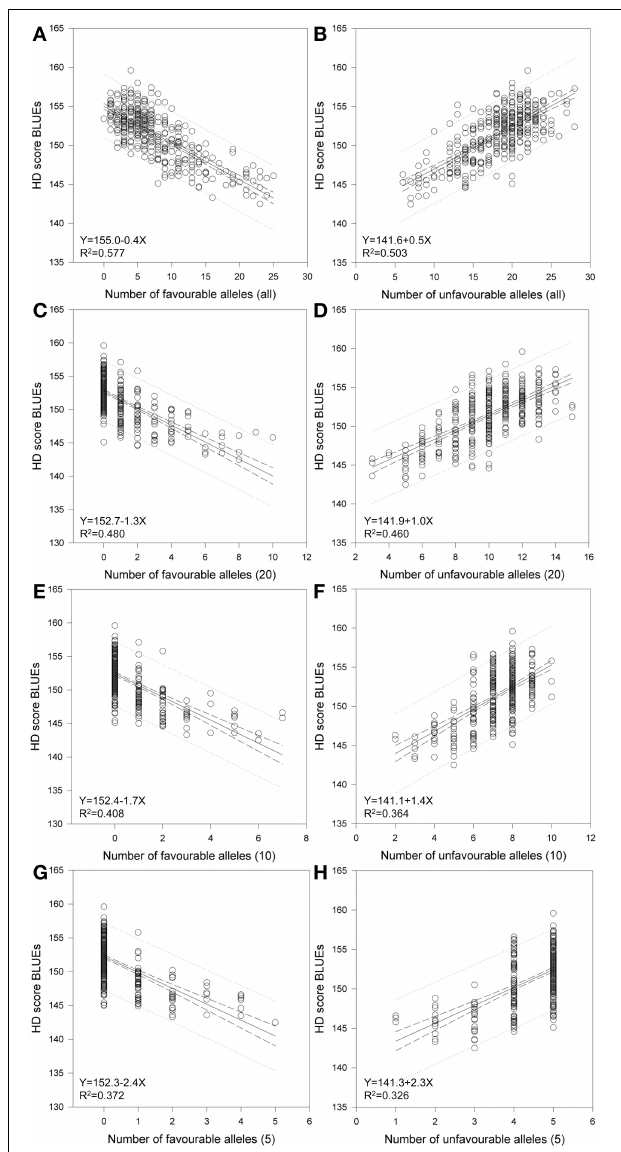
FIGURE 6 | Regression of favorable and unfavorable HD alleles. Linear regression resulted in a relationship of HD-BLUEs score and number of favorable and number of unfavorable alleles in 372 wheat varieties. The calculations were performed for (A) all favorable and (B) all unfavorable alleles and included the SSR marker with significant association with a − log 10 ( P -value) ≥ 3.0. Additional calculation were done by taking the (C) 20 best and (D) 20 worst alleles, the (E) 10 best and (F) 10 worst alleles as well as the (G) 5 best and (H) 5 worst alleles, which included the candidate gene Ppd-D1